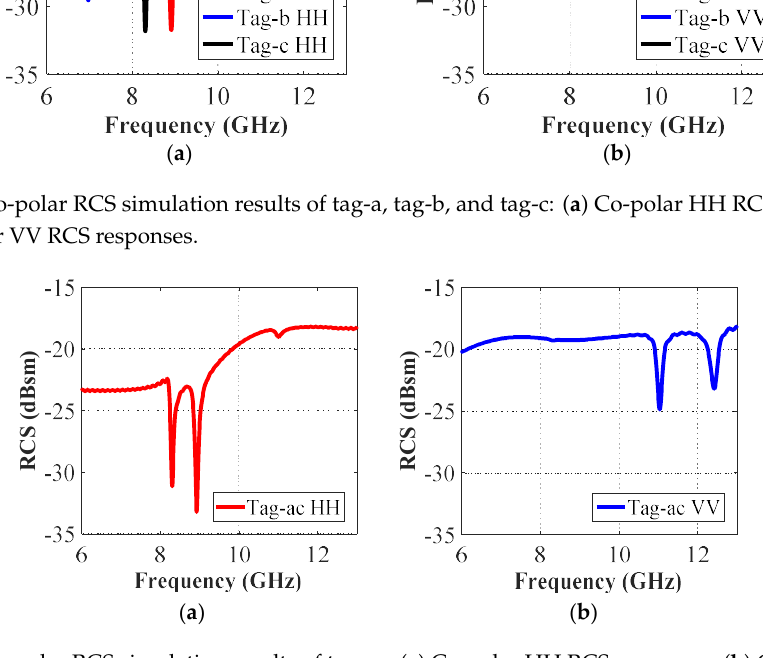
Figure 7. Co-polar RCS simulation results of tag-ac: ( a ) Co-polar HH RCS responses; ( b ) Co-polar VV RCS responses.